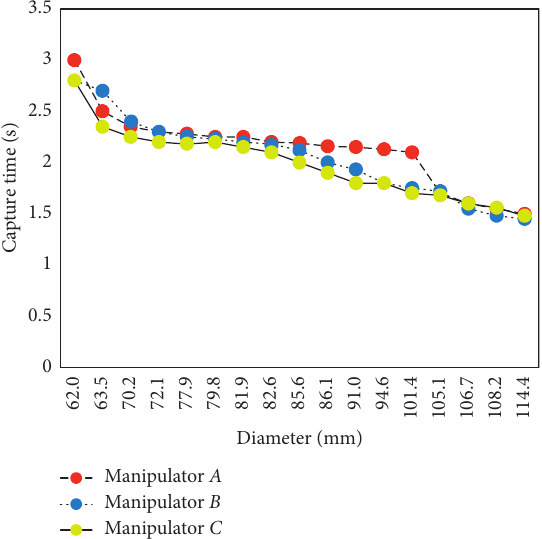
Figure 15: Capture time of grasping diameter.